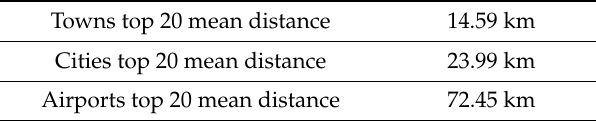
Table 2. Average distance with top 20 highest similarity locations.